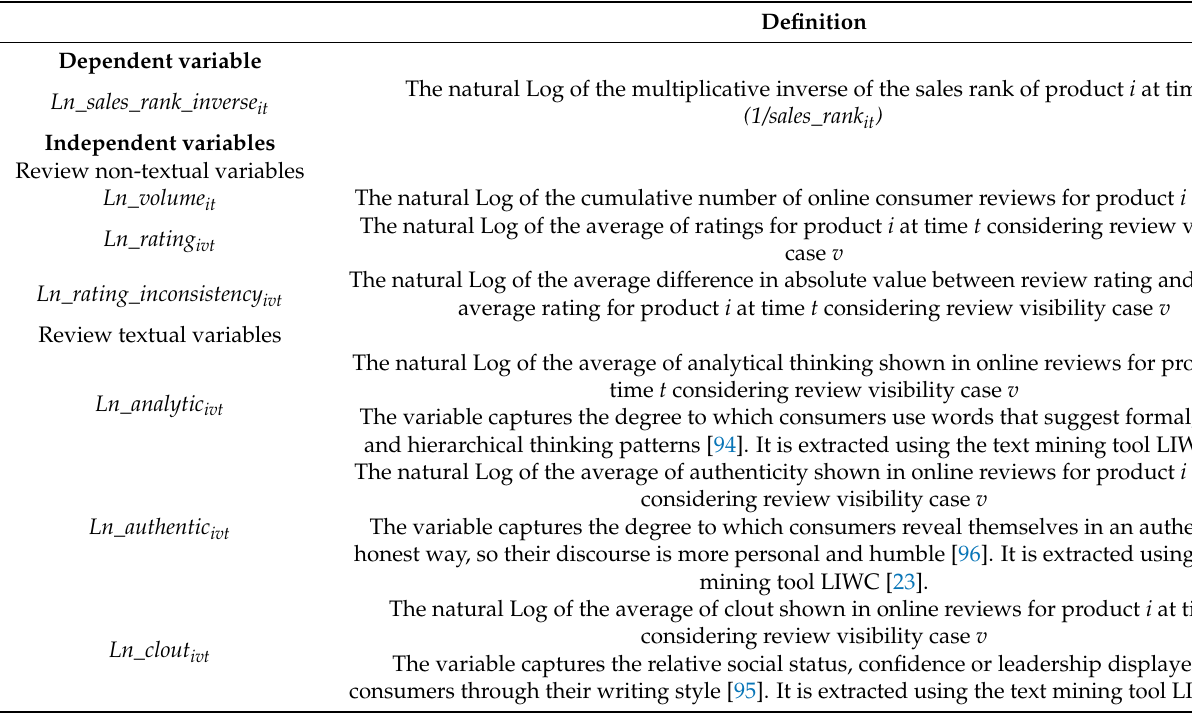
Figure 2. Example of review information collected from the online retailer. Table 1. Research variables.